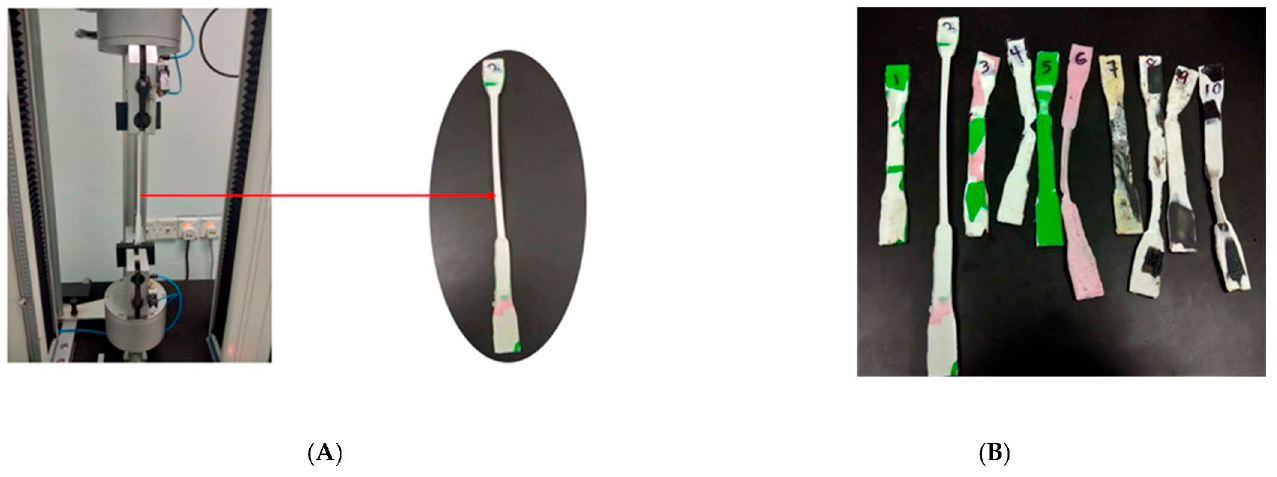
Figure 9. ( A ) Tensile strength test for ratio 100% of HDPE (100H). ( B ) Test pieces for ratio 100% of HDPE (100H) after testing.